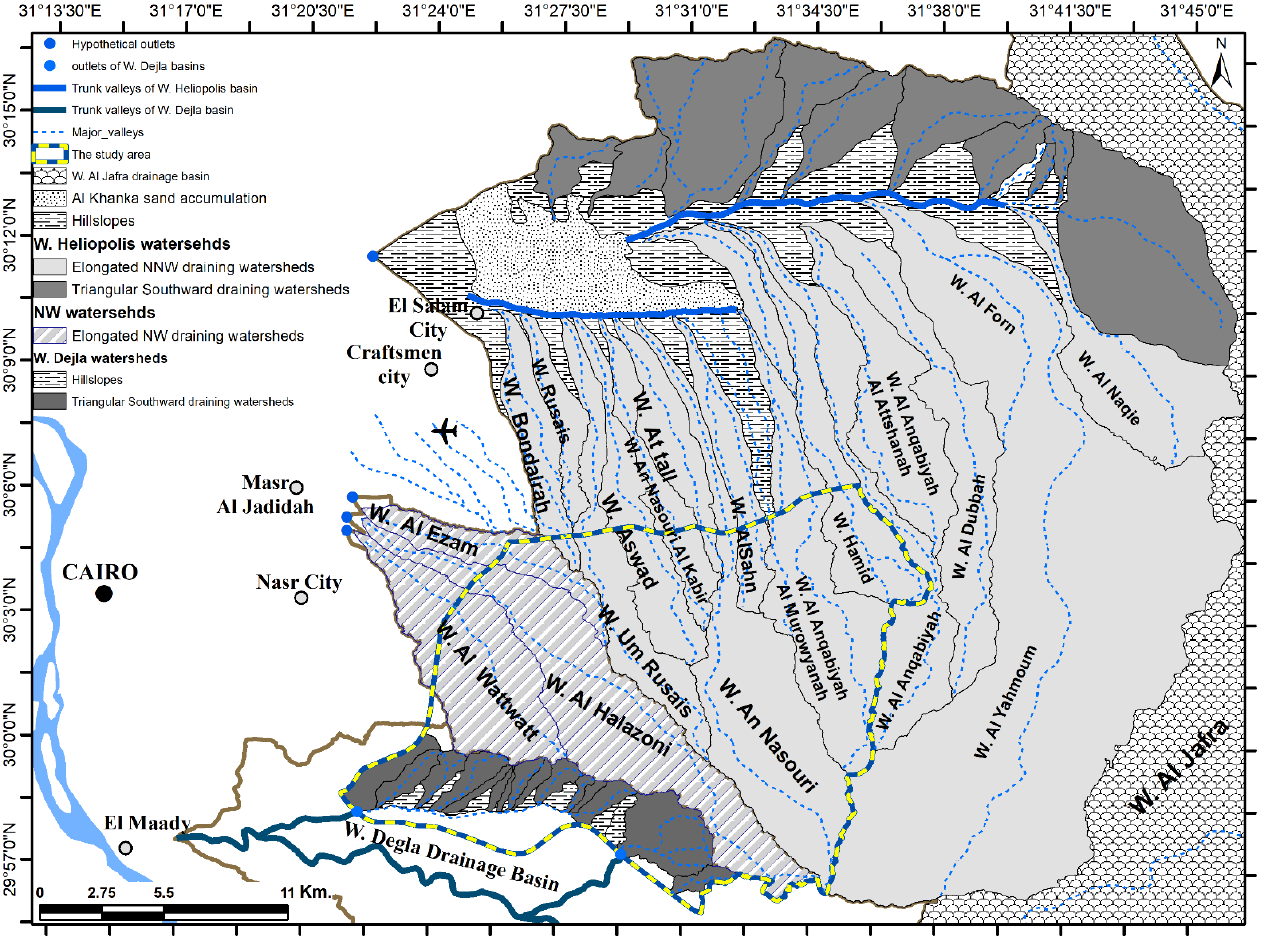
Figure 4. Regional morphologic and geospatial setting of the major drainage basins and their sub- watersheds in East Cairo.